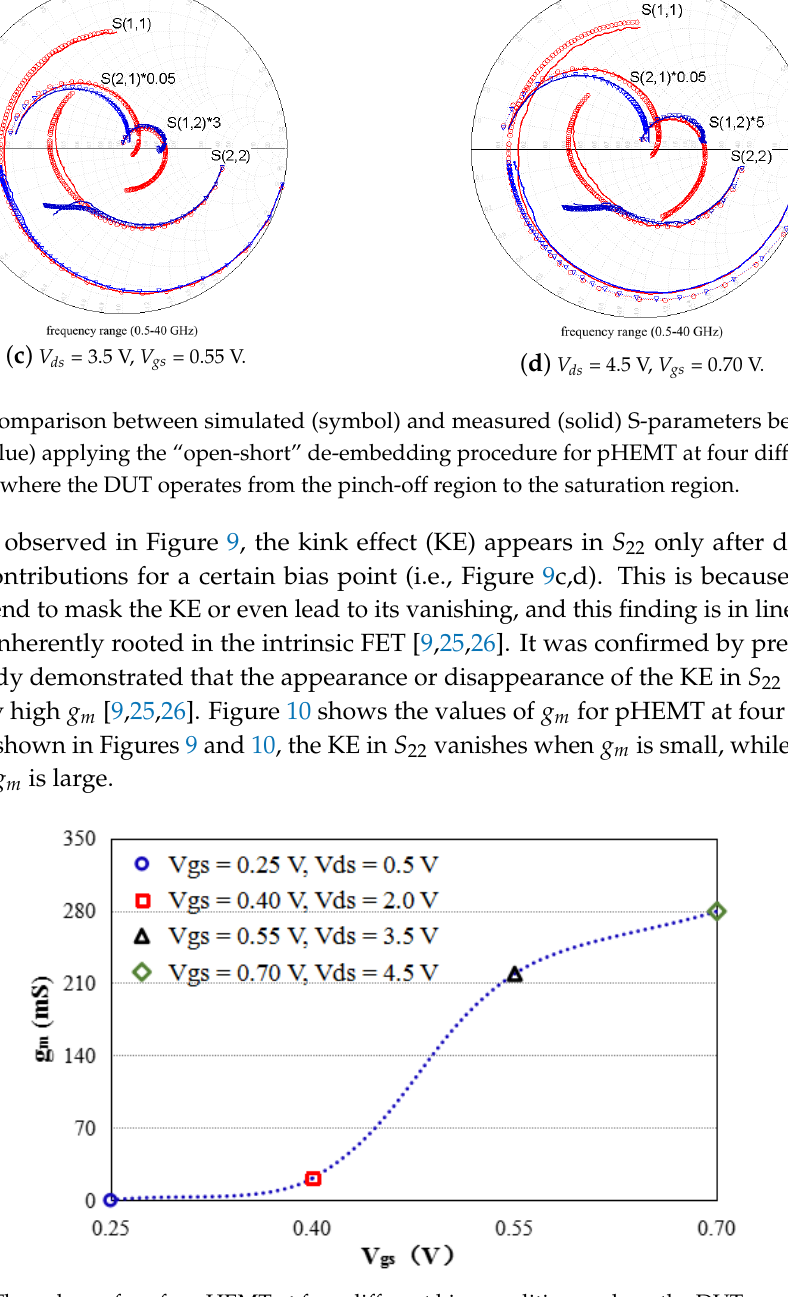
Figure 10. The values of g m for pHEMT at four different bias conditions, where the DUT operates from the pinch-off region to the saturation